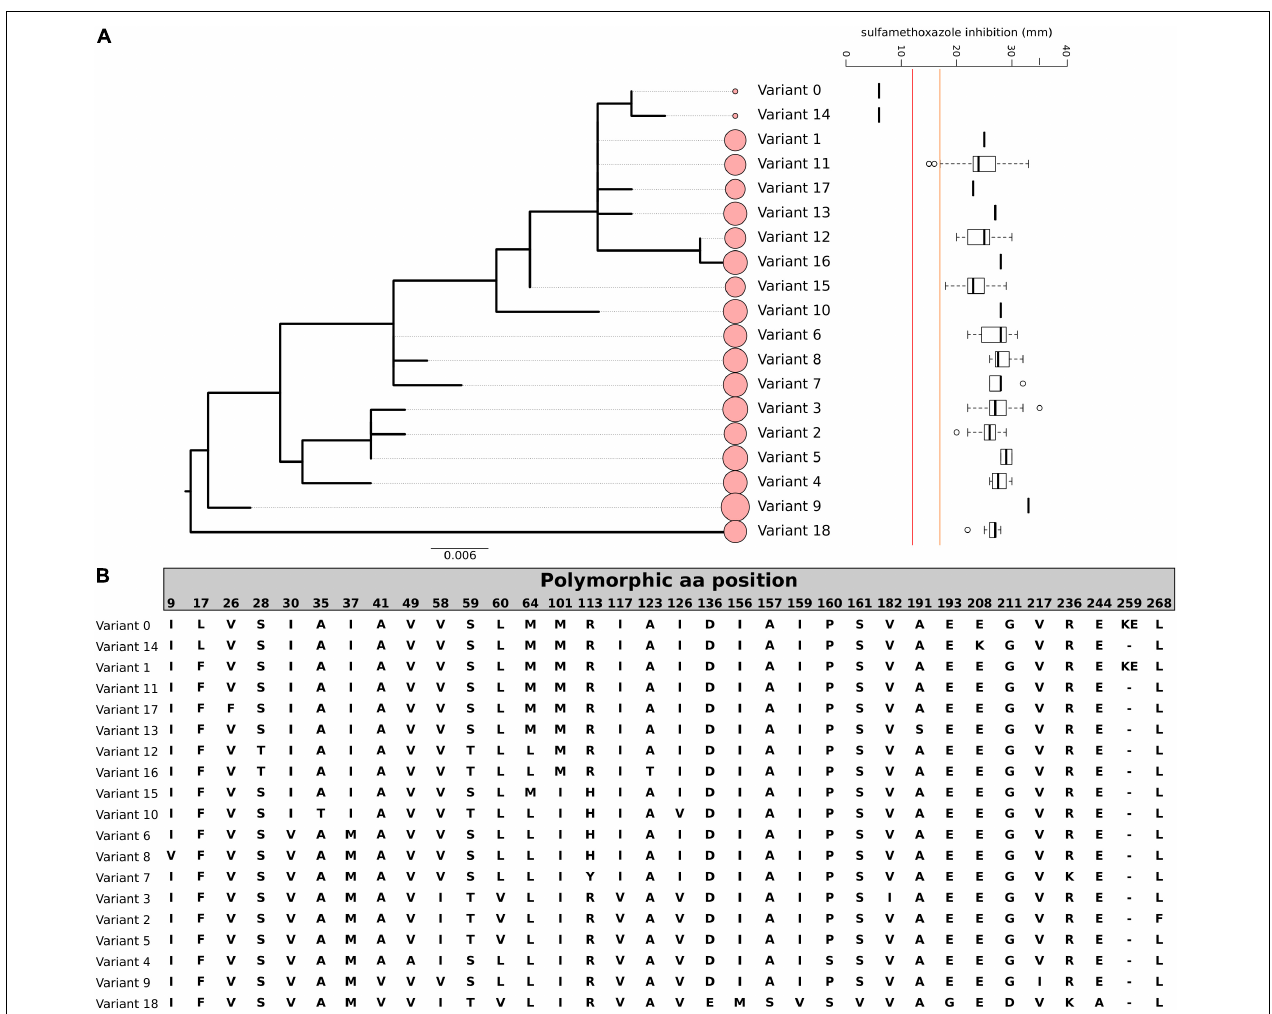
FIGURE 2 | Genomic variation of DHPS among our study cohort. (A) Phylogenetic relationship of the 19 variants of DHPS (var. 0–18) and the corresponding SMZ resistance (red line indicates the CLSI cut-off for SMZ resistance, orange line indicates the cut-off for SMZ susceptibility, intermediate range between red and orange line, the size of the circles indicate the number of isolates in the variant cluster). The tree is based on the nucleotide sequence and rooted at midpoint. (B) Amino acid sequence of the 19 DHPS variants detected. Only polymorphic sites are displayed. The order corresponds to the phylogenetic tree